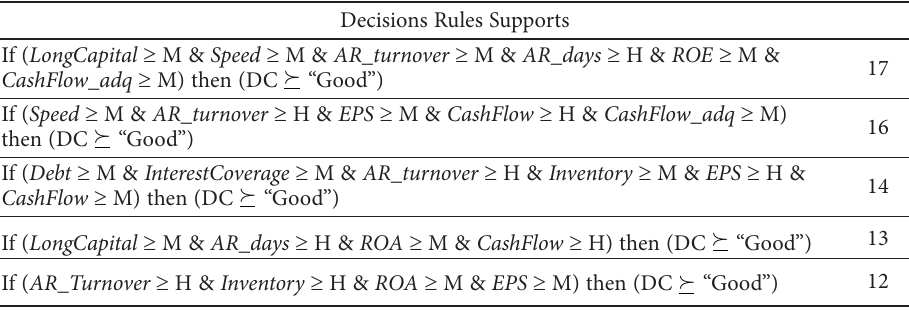
Table 4. Decision rules associated with at least “Good” decision class Decisions Rules